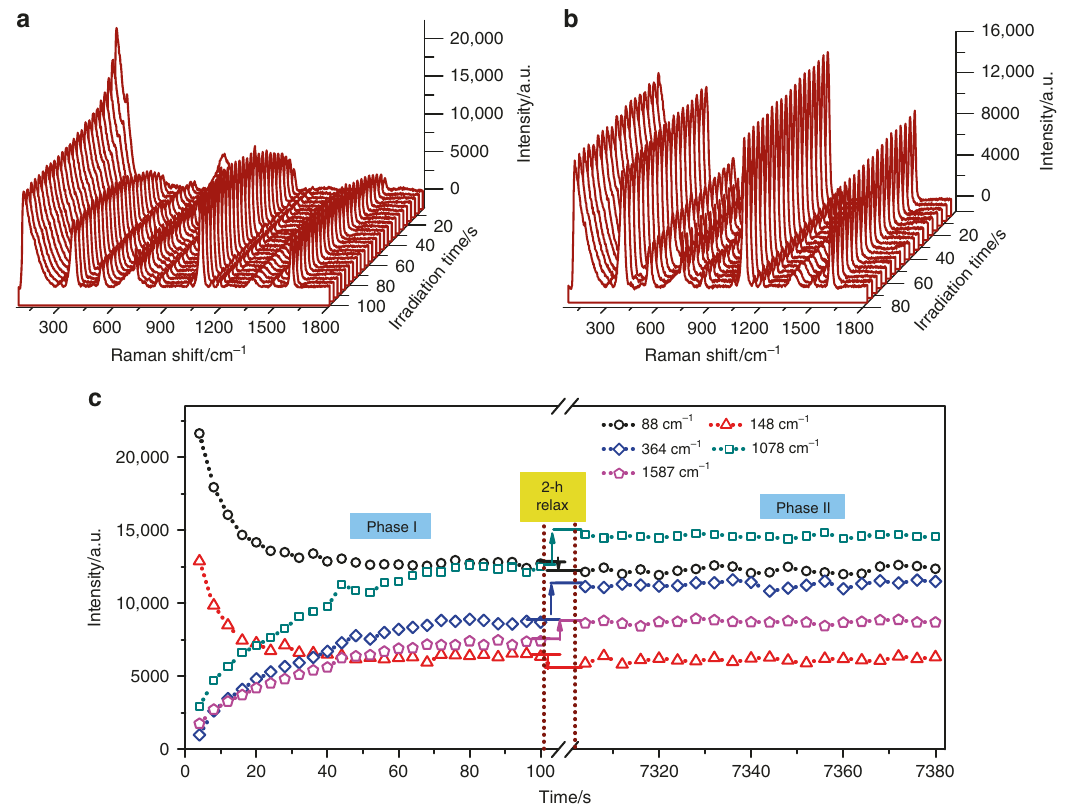
Fig. 3 Irreversible accumulated SERS behaviors. a NIR irradiation-induced SERS spectra of the 4MBA/Ag/Ag-doped TiO 2 hybrid system; b NIR irradiation-induced SERS spectra of the 4MBA/Ag/Ag-doped TiO 2 hybrid system after 2 h relaxation without irradiation; c Temporal evolutions of the Raman peak intensities at 88, 148, 364, 1078, and 1587 cm − 1 . Phase I: the SERS signals under continuous irradiation (100 s); phase II: after 2 h relaxation without irradiation and then under continuous irradiation (80 s). Here, the temporal evolutions of other bands of 4MBA, such as 525, 718, and 842 cm − 1 , are not displayed due to their relative weak signal and same